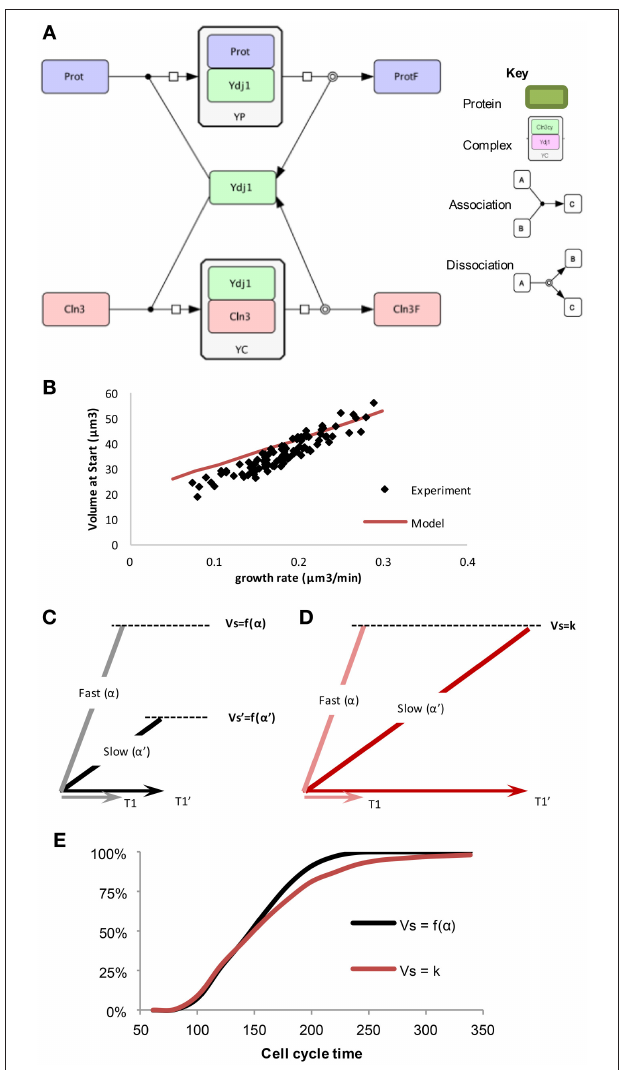
FIGURE 2 | The “speedometer” model of cell growth rate—critical cell size coupling. (A) Competition between prot and Cln3 for free Ydj1 , drawn in CellDesigner (http://www.celldesigner.org/). (B) The “speedometer” model qualitatively predicts cell size as a function of growth rate. Experimental data as in Figure 1C . (C,D) Length of G1 (T1) have a larger noise and slow growing cells have much longer G1 in the model with fixed critical size, compared to G1 length in a growth rate dependent critical size model. (E) Cumulative distribution of cells finishing the cell cycle starting from a population of random newborn daughter cells in the two sizer models (Ferrezuelo et al.,